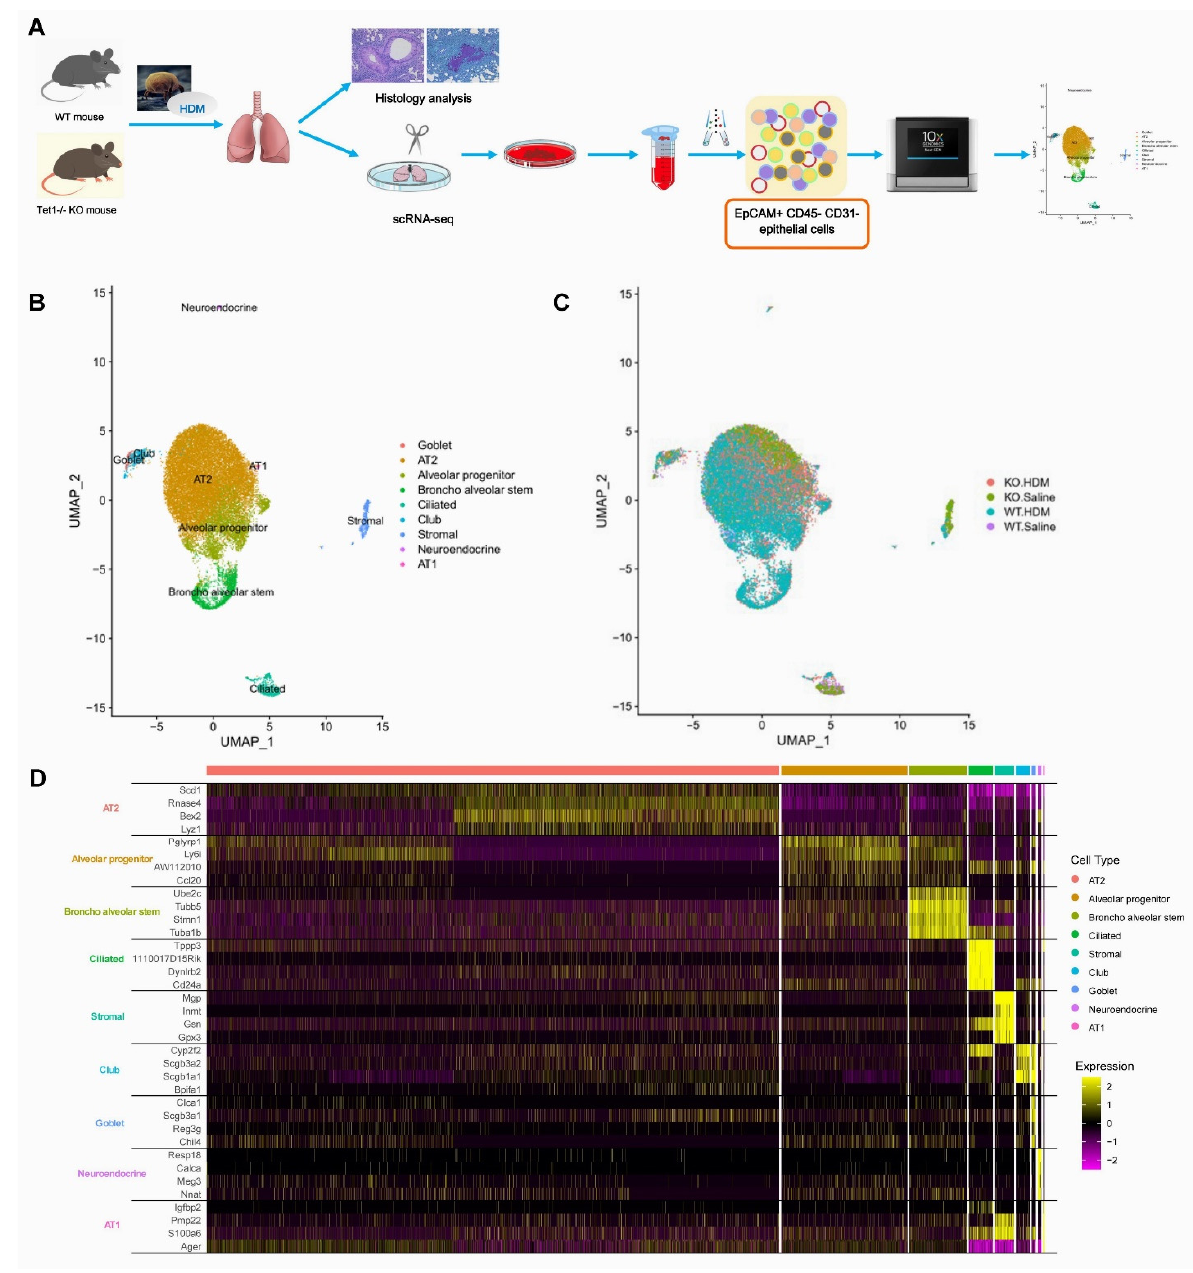
Figure 1. Single-cell RNA sequencing clustering analysis identifies 9 cell types in EpCAM + CD45 − CD31 − lung cells. ( A ) Schematic overview of the study workflow. ( B ) UMAP visualization of clustering, revealing 9 cell populations. Population identities were determined based on marker gene expression. ( C ) UMAP visualization of EpCAM + CD45 − CD31 − lung cells in Tet1 KO mice and WT mice with and without HDM challenge. ( D ) Heatmap of top 4 markers in 9 cell